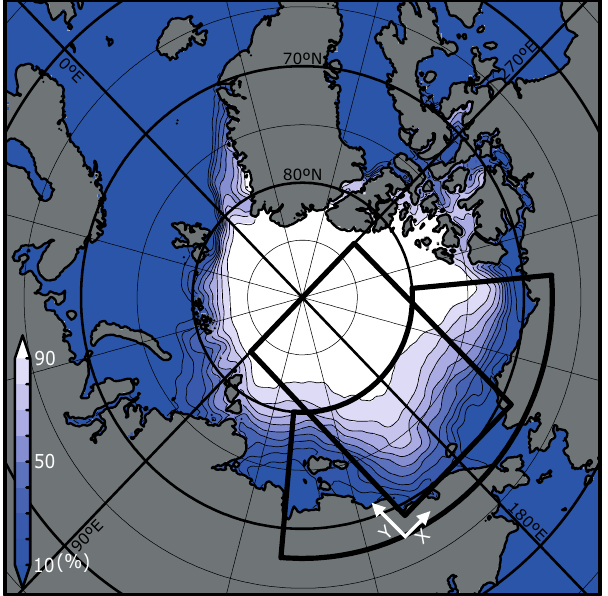
Figure 1. Map of the Arctic Ocean with September sea ice concentration averaged from 1979 to 2014. The heat budget analysis and calculation of ice divergence were made for the fan-shaped area. The simplified model was applied for the rectangular area. The map is drawn by GrADS 2.0.2 (available from http://cola.gmu.edu/grads/